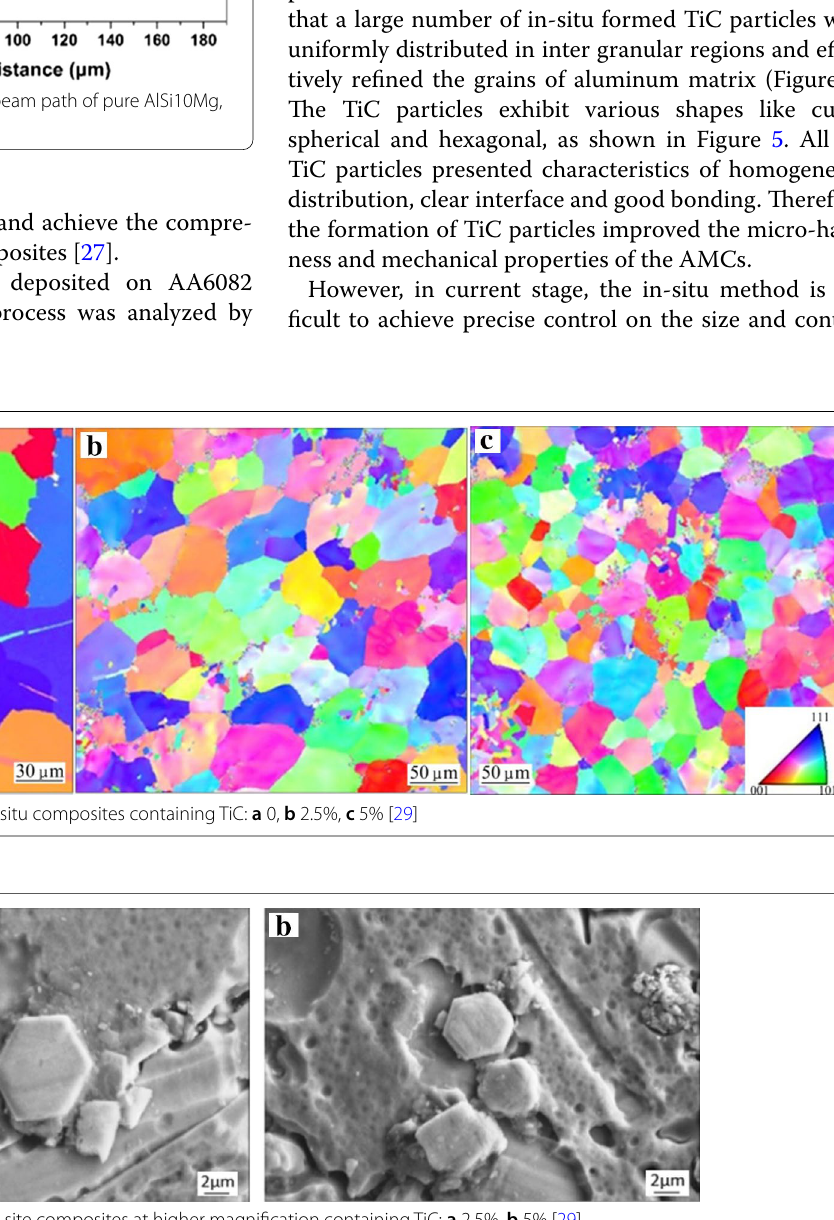
Figure 5 SEM images of AA6061/TiC in site composites at higher magnification containing TiC: a 2.5%, b 5%